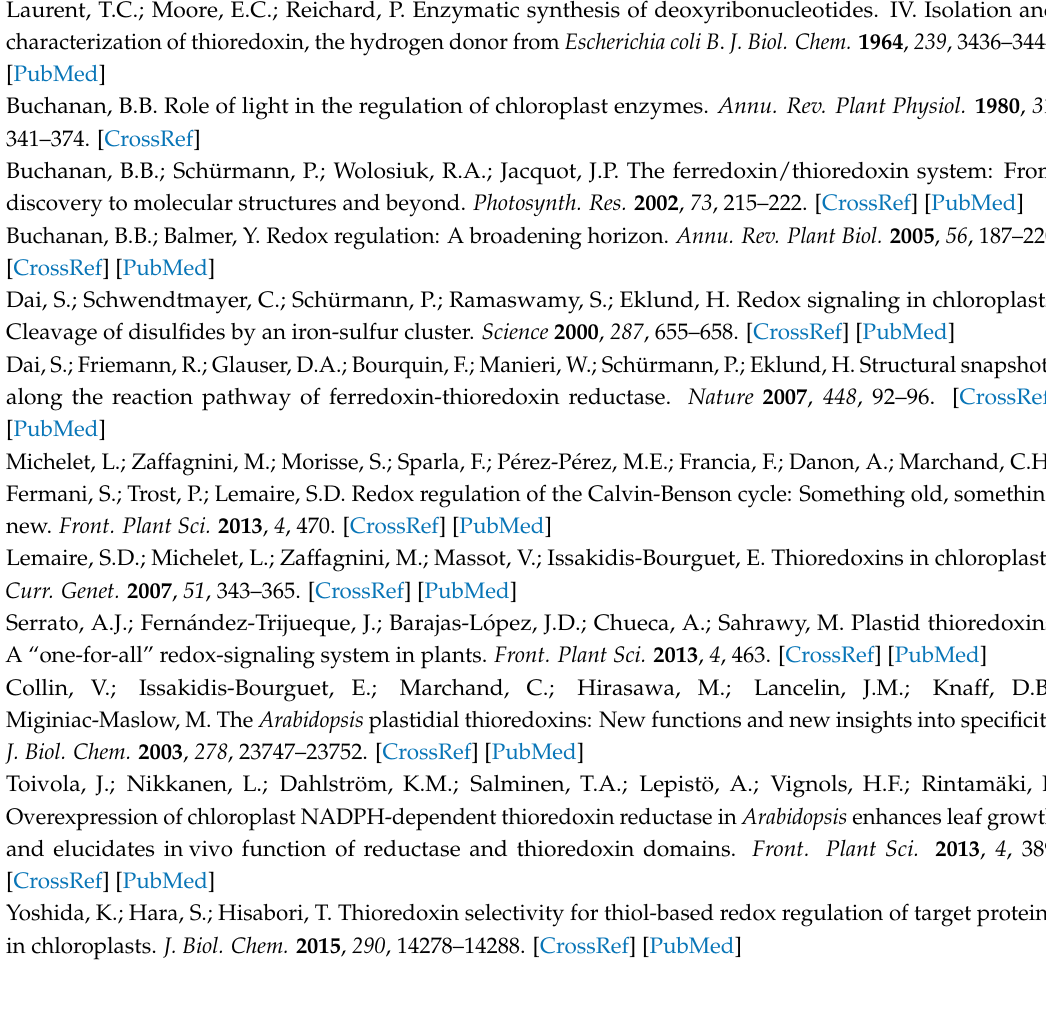
Figure S1: Trx selectivity for reducing FBPase, SBPase, and RCA in the reconstituted FTR/Trx system in Arabidopsis , Figure S2: The in vitro redox responses of FTR-C, Trx- f 1, and target proteins from Arabidopsis (pH